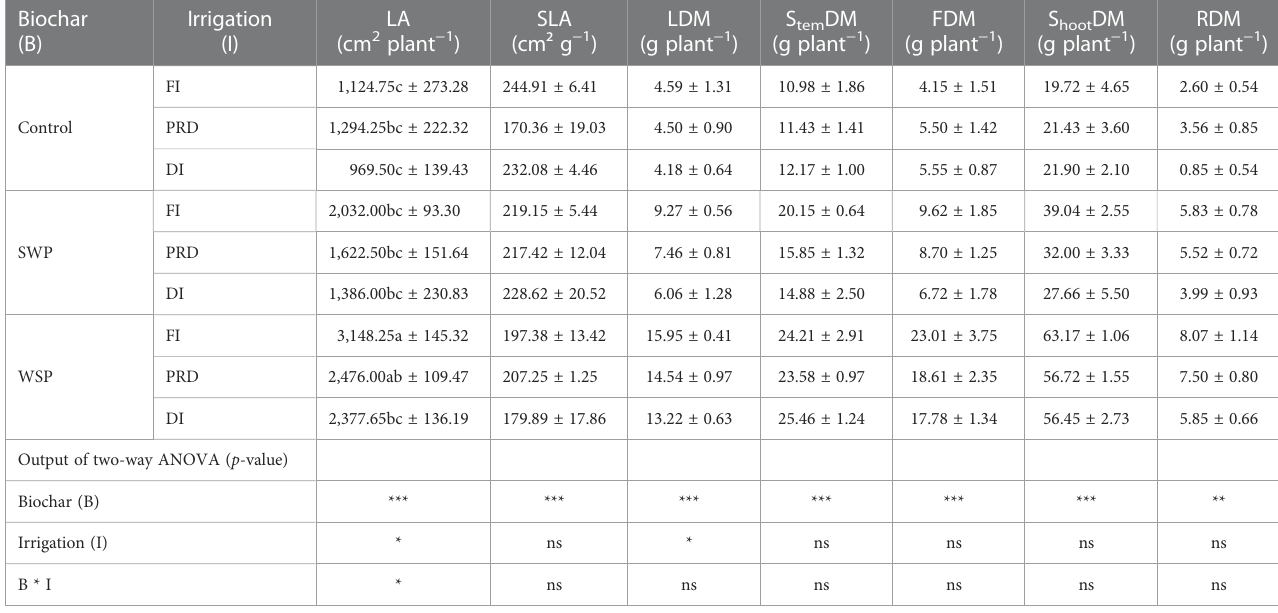
TABLE 6 The effects of treatments and output of two-way ANOVA for leaf area (LA), speci fi c leaf area (SLA), leaf dry matter (LDM), stem dry matter (S